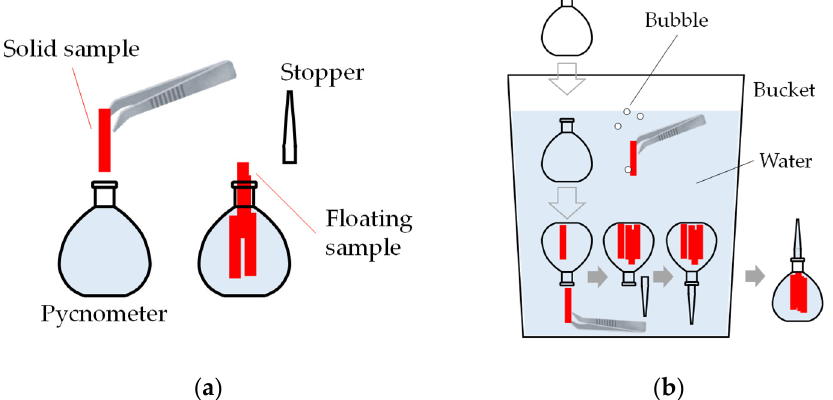
Figure 1. ( a ) Density measurement by the pycnometer method for a solid sample with a density lower than that of pure water. The solid sample floats, and the pycnometer cannot be capped. ( b ) Density measurement by turning the pycnometer upside down in the water.